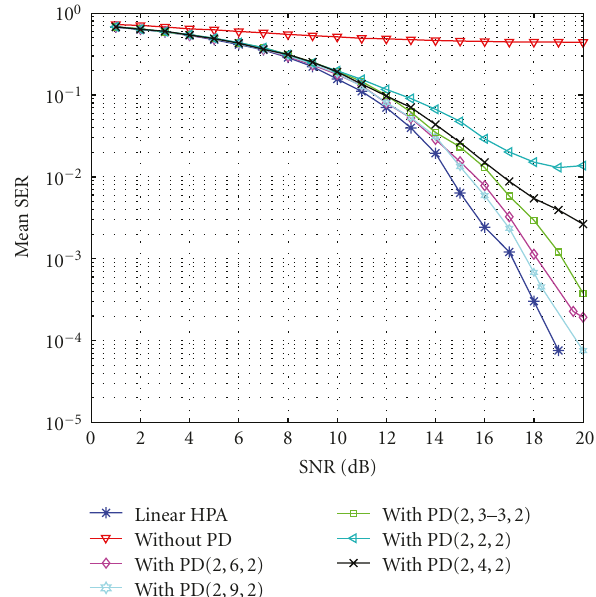
Figure 12: Symbol error rate of the OFDM system with predistorter versus SNR: a 16-QAM modulation is used on 64 carriers and IBO = 8